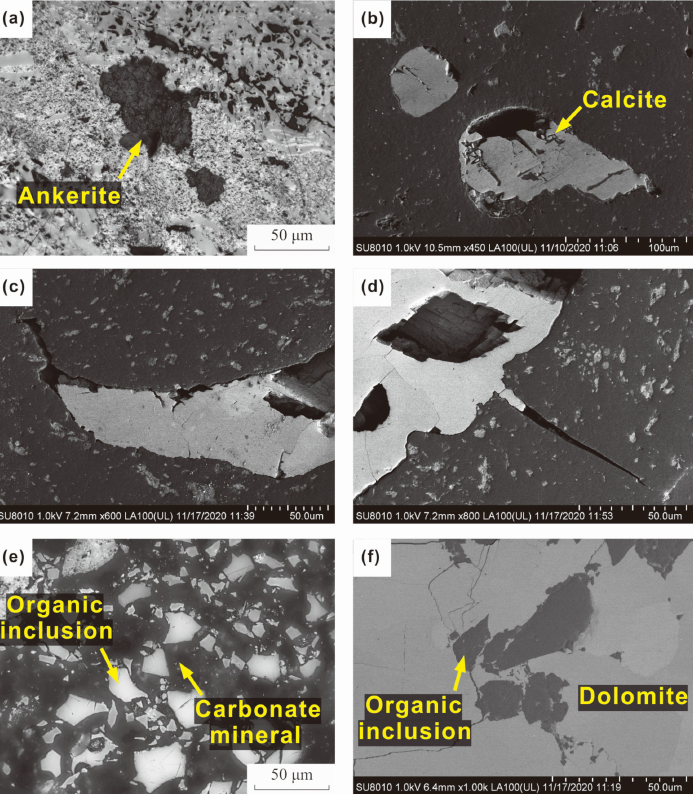
Figure 10. Epigenetic carbonate minerals in the thermally altered Tashan coal: ( a ) epigenetic con- cretion of ankerite, white reflected light and immersion oil under the optical microscope; ( b ) calcite in devolatilization vacuoles, BSE; ( c ) dolomite filling the cleat, BSE; ( d ) a fissure filled by dolomite, BSE; ( e ) organic inclusion in epigenetic carbonate minerals, reflected light by optical microscope; ( f ) organic inclusion in dolomite,